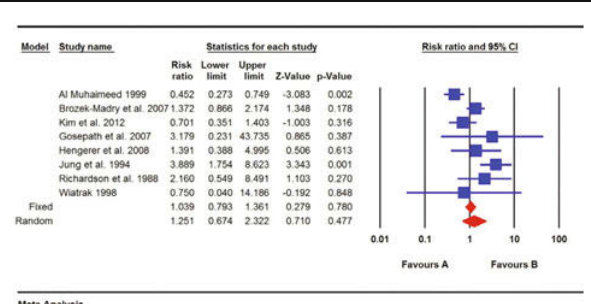
Forest plot for the incidence of restenosis after transnasal or trans- palatal repair using the estimated risk ratio (RR) as the effect measure. CI, confidence interval.